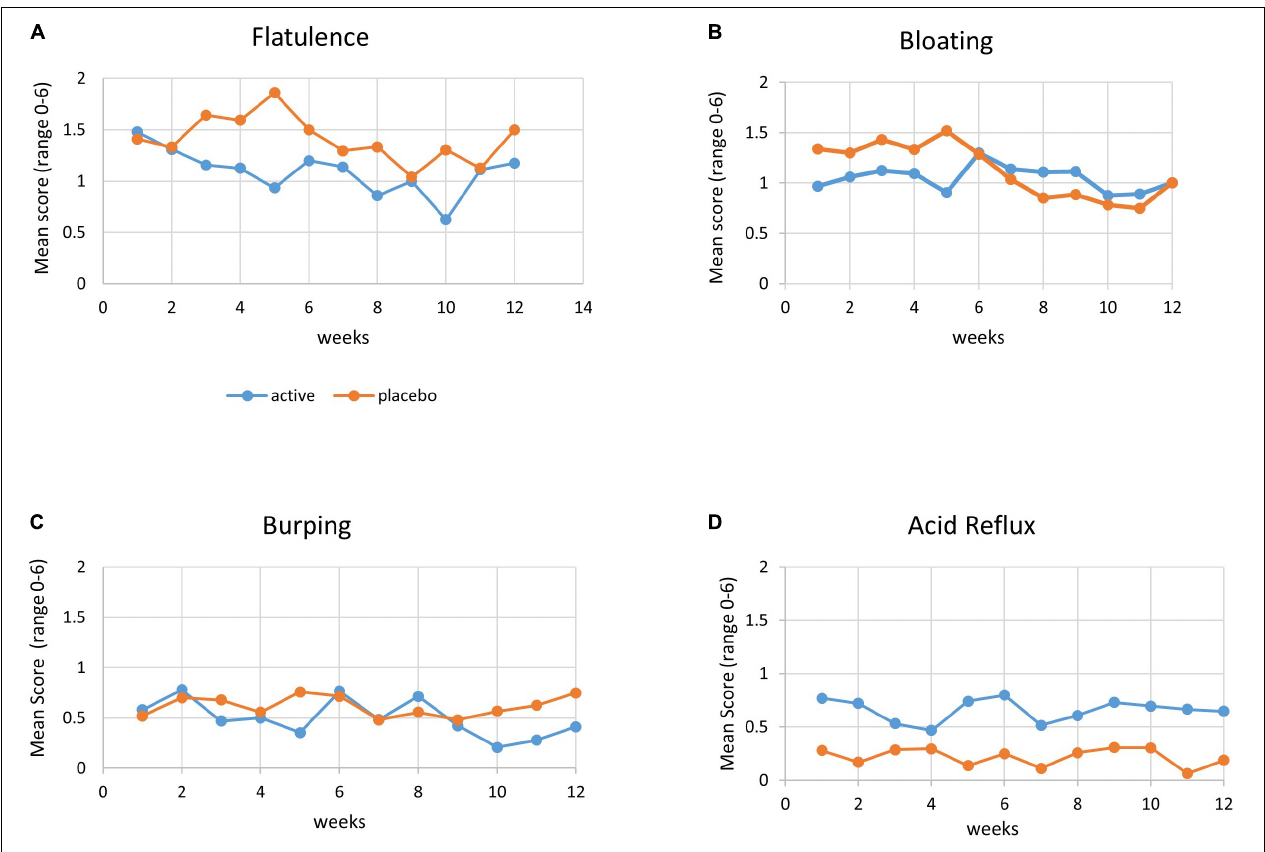
FIGURE 4 | Gastrointestinal symptoms. Mean score of gastrointestinal symptoms (range 0–6, with 0 = no symptoms and 6 = severe symptoms) by week, with active group (blue line) and placebo group (orange line). (A) Flatulence, (B) bloating, (C) burping, and (D) acid